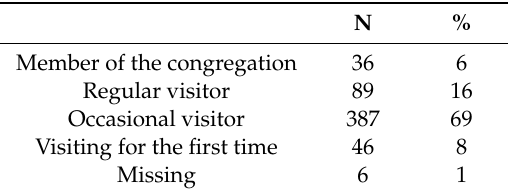
Table 6. Connection with Liverpool Cathedral.